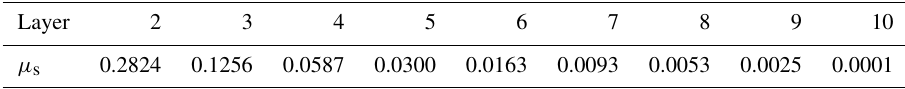
Table 2. Estimated localization scale factor for different